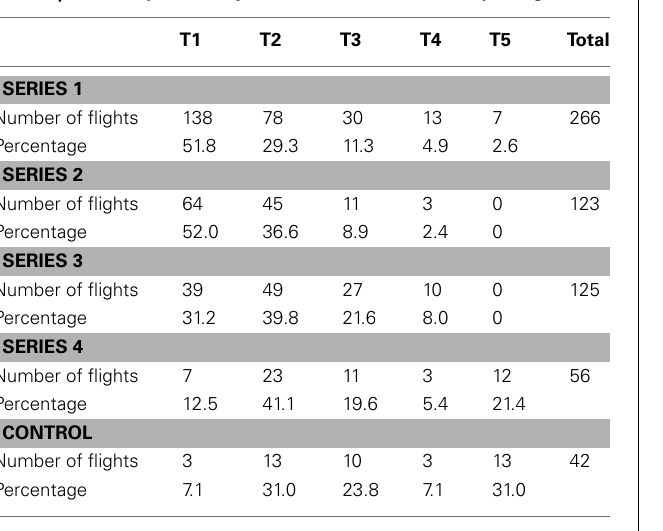
Table 1 | Summary of maze performance as evaluated by categories.